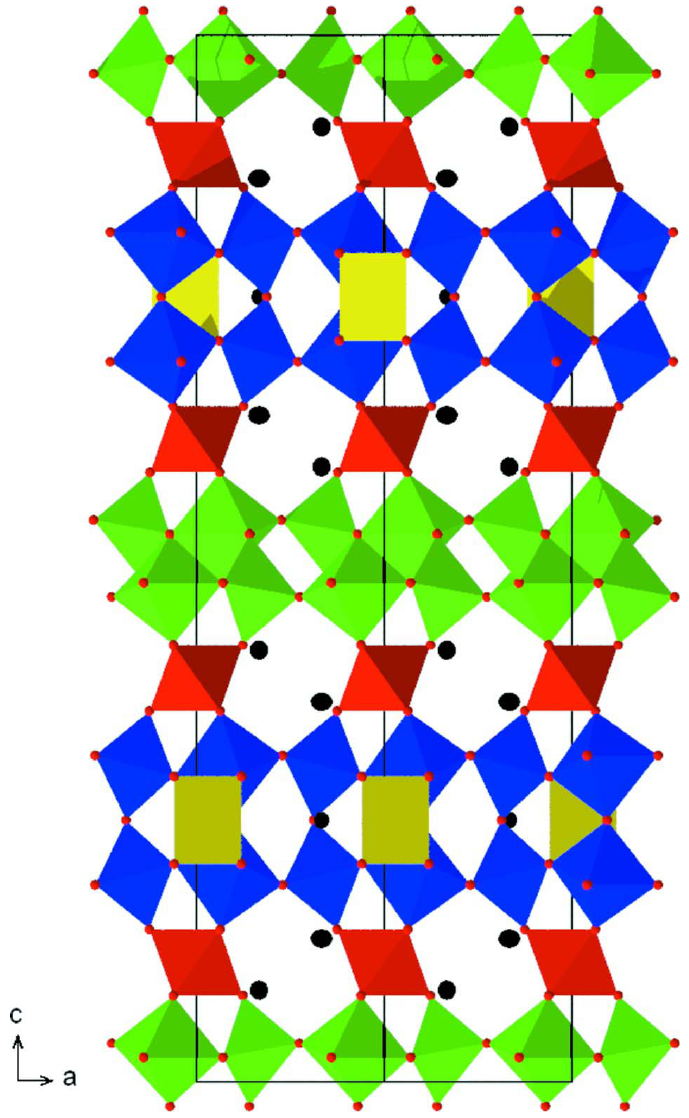
octahedra. Displacement ellipsoids are drawn at 6